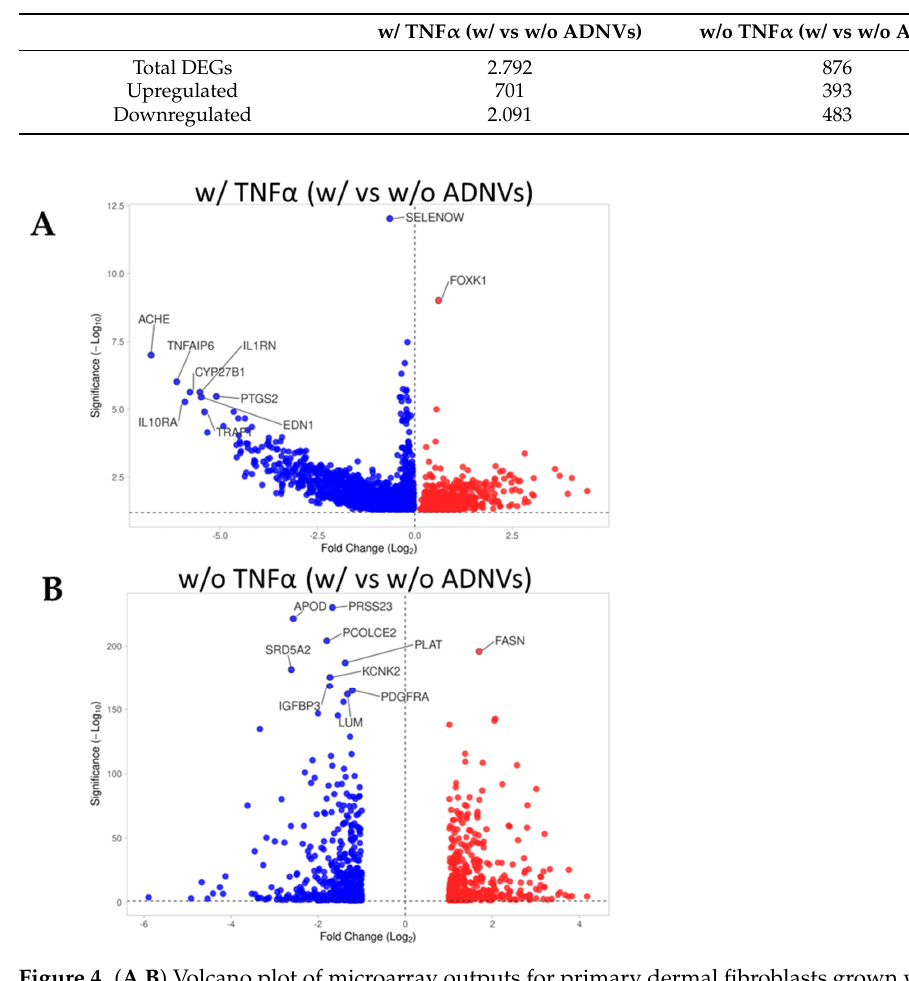
Table 3. General data distribution of microarray analysis and comparison.